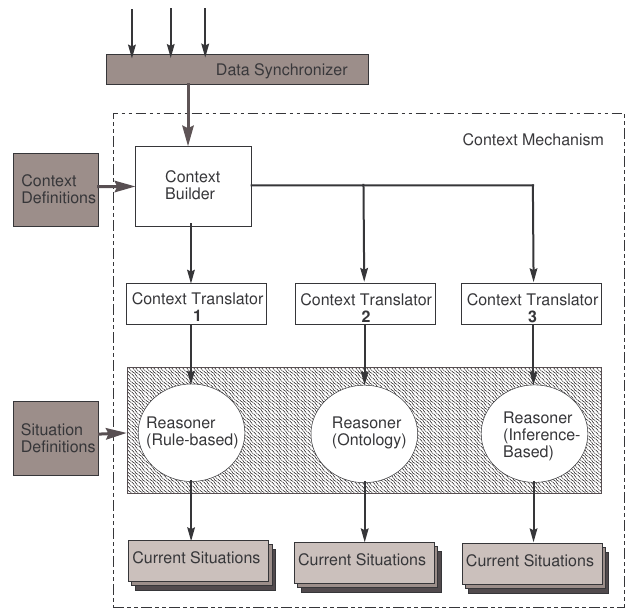
Figure 5. Detailed View of The Context